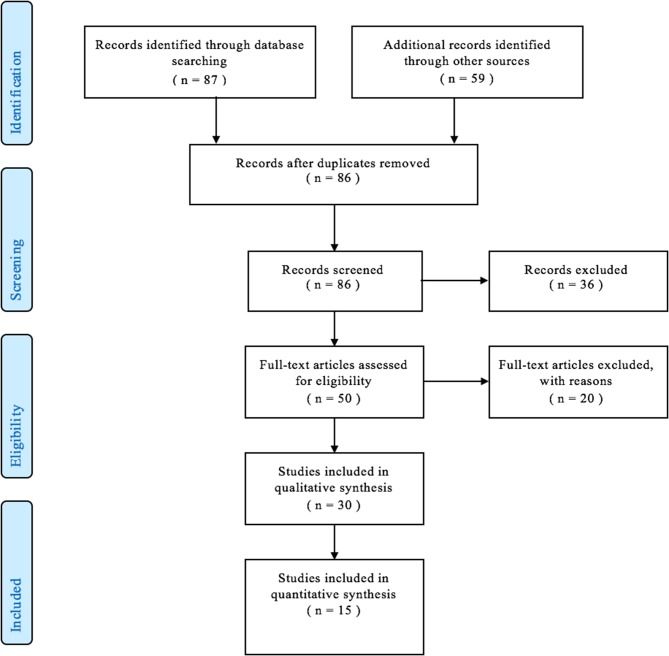
Preferred reporting items for systematic reviews and meta-analyses flowchart showing the resulting articles after implementing inclusion and exclusion criteria.